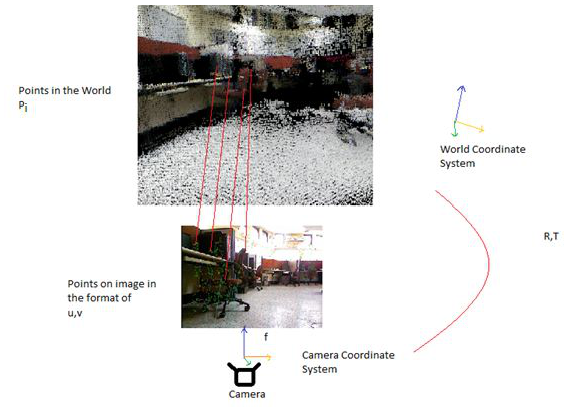
Figure 3: Transformation from 2-D image to 3-D world coordinates. This image shows the correspondence between points on the image ( u, v ) and in the physical world, i.e., P i .